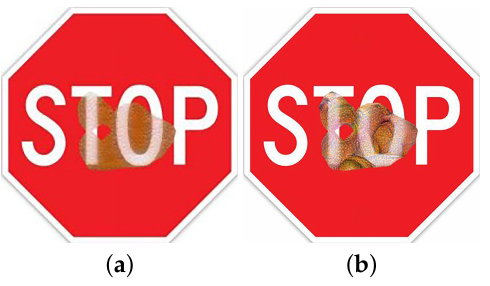
Figure 10. Results of the different camouflage losses: ( a ) is the original image, ( b ) is the example generated only with L content , ( c ) is the example generated only with L style and ( d ) is camouflaged adversarial examples with both two kinds of loss functions.